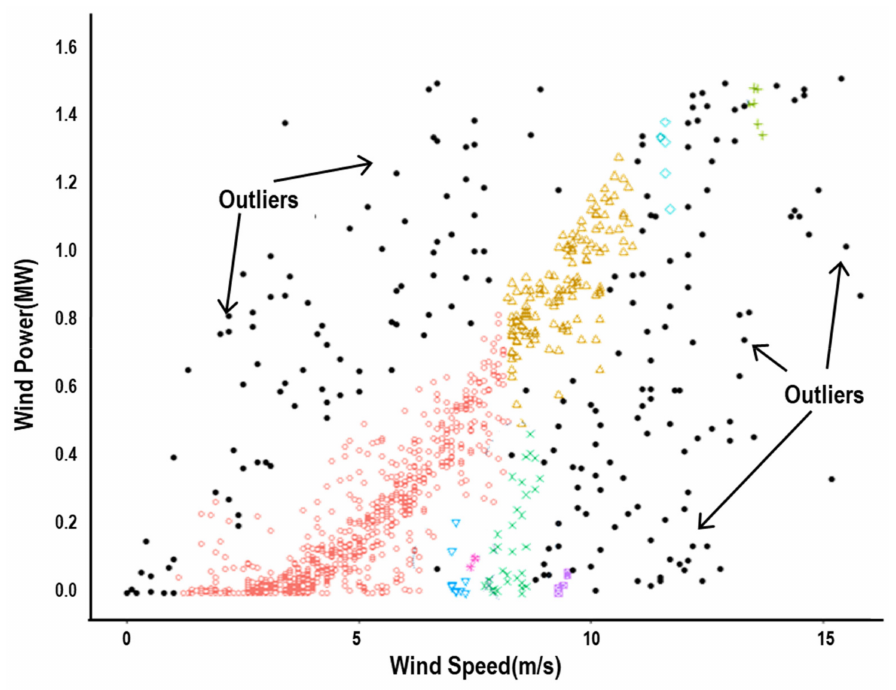
Figure 4. Outliers from DBSCAN